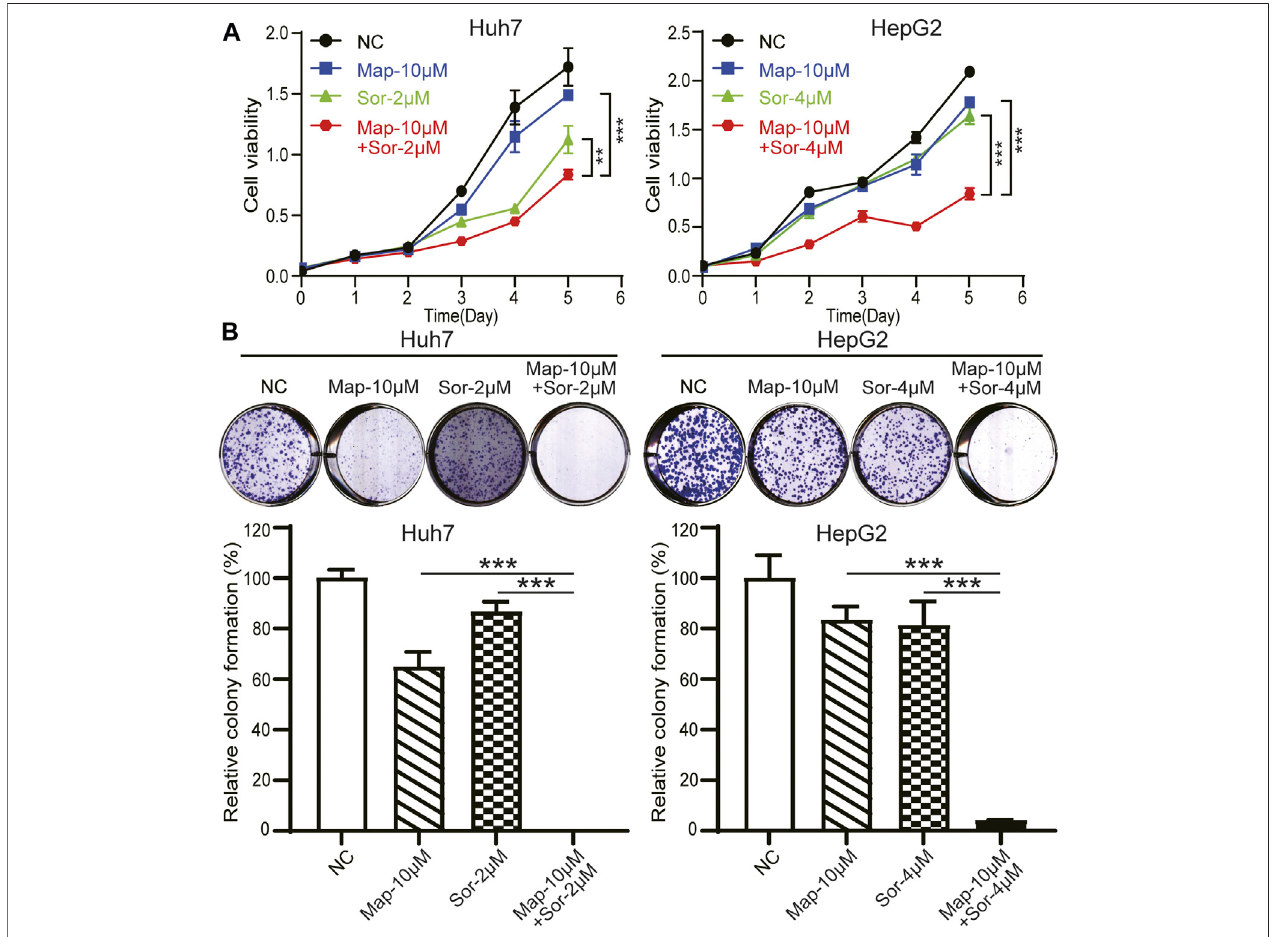
FIGURE3| MaprotilineincombinationwithsorafenibinhibitsthegrowthofHuh7 andHepG2HCCcells. (A) CellviabilityassaysofHuh7andHepG2cellsexposed to maprotiline alone or in combination with sorafenib for 0, 24, 48, 72, 96, and 120 h. (B) Colony formation assays of Huh7 and HepG2 cells under 10 μ M maprotiline treatment alone or with